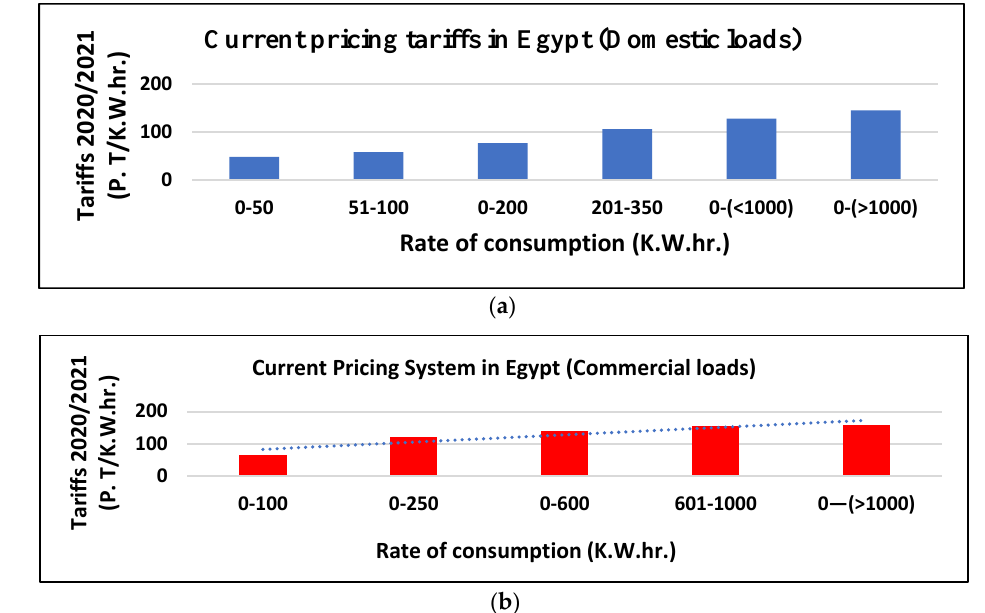
Figure 7. The 2021/2022 electricity tariffs for various loads. ( a ) The 2021/2022 electricity tariffs versus the consumption rate for domestic loads. ( b ) The 2021/2022 electricity tariffs versus the consumption rate for commercial loads.